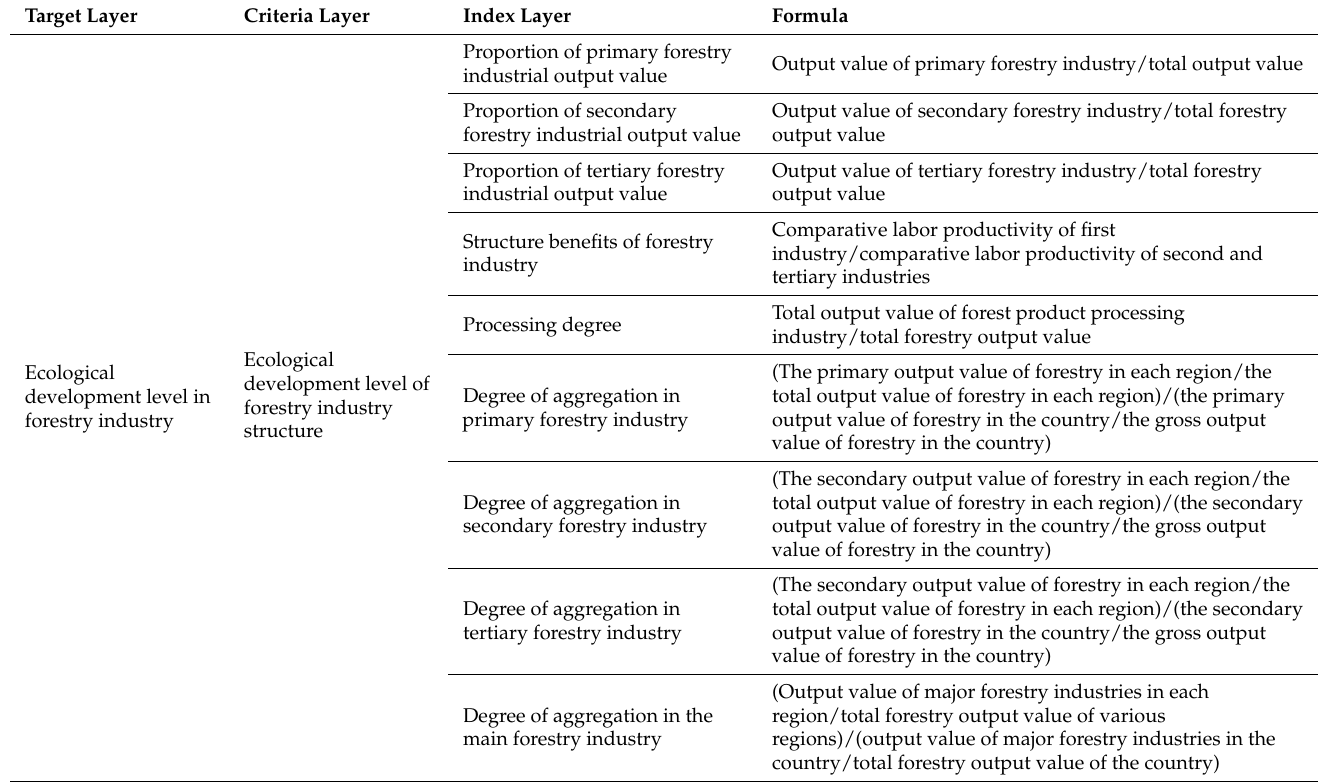
Table 1. Evaluation index system of the ecological development level in the forestry